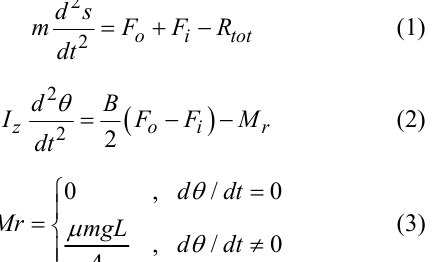
Figure 2. Fuel map contour of ICE